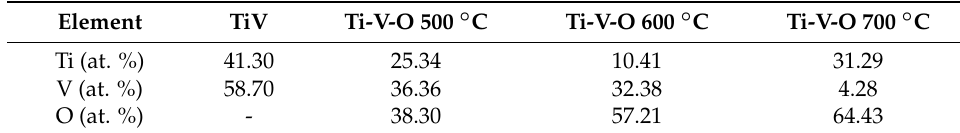
Figure 2. Surface morphology of the TiV coatings and the Ti-V-O coatings following HTA. ( a ) TiV; ( b ) Ti-V-O 500 ◦ C; ( c ) Ti-V-O 600 ◦ C; ( d ) Ti-V-O 700 ◦ C. Table 1. Energy dispersive spectroscopy (EDS) element mapping results of the TV coatings and the Ti-V-O coatings following HTA.